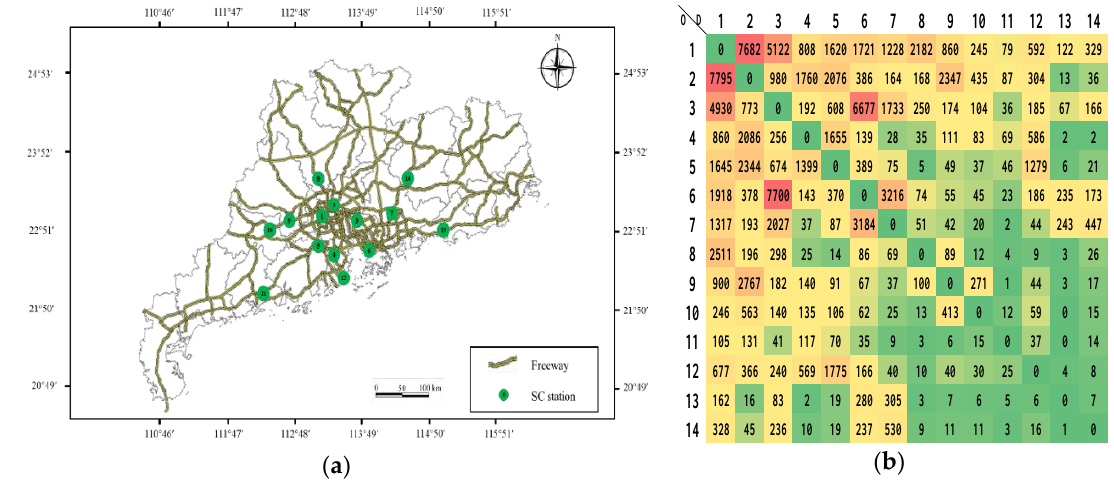
Figure 5. The input data for this numerical example: ( a ) designed BSSs in Guangdong Province, China; ( b ) origin and destination (OD) demand distribution.